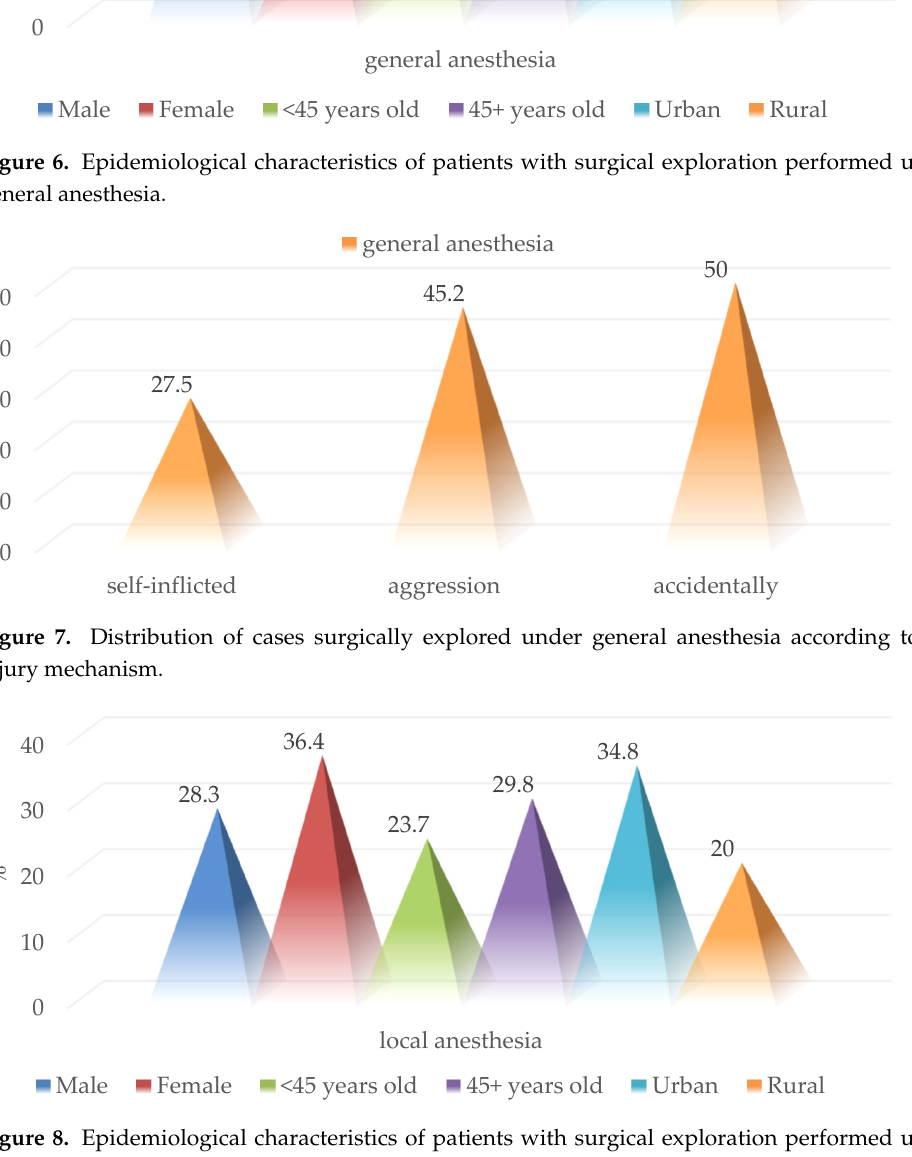
Figure 8. Epidemiological characteristics of patients with surgical exploration performed under local anesthesia.